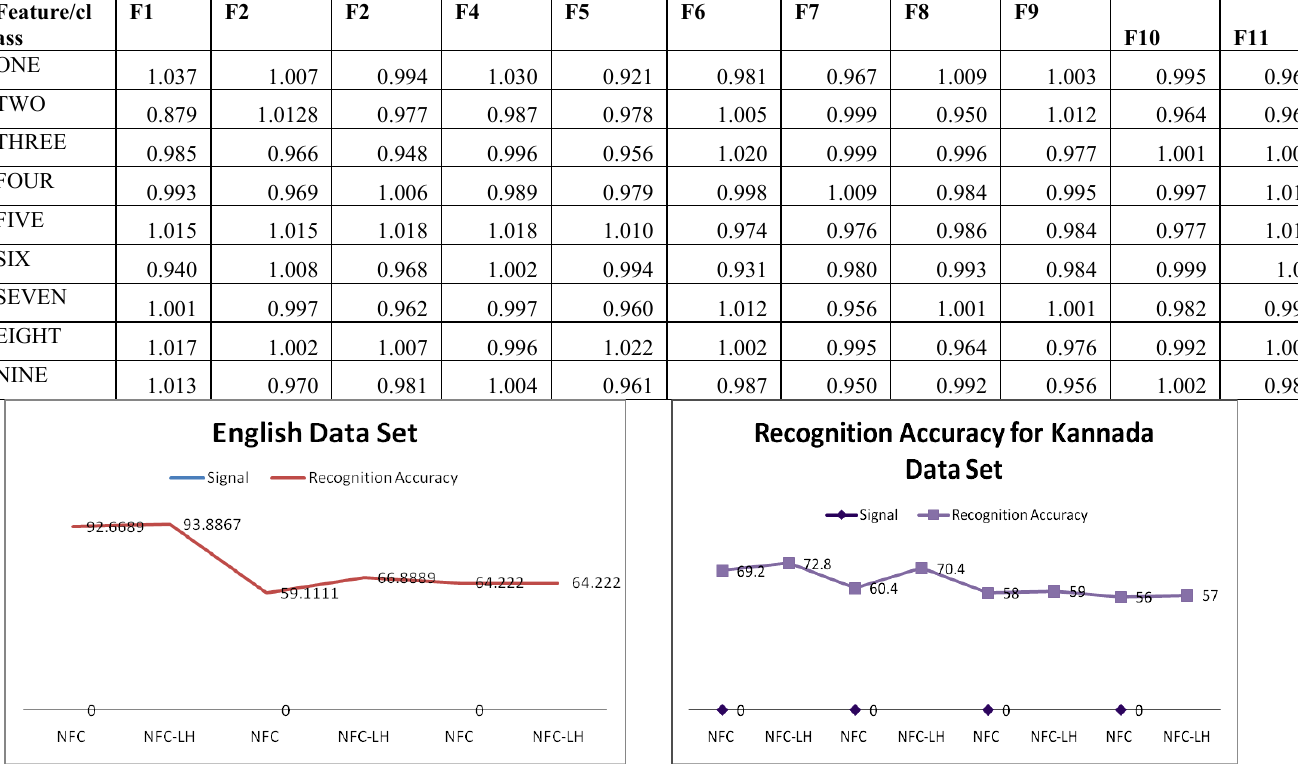
Figure 4. Recognition accuracy for English Dataset Figure 5. Recognition accuracy for Kannada Dataset